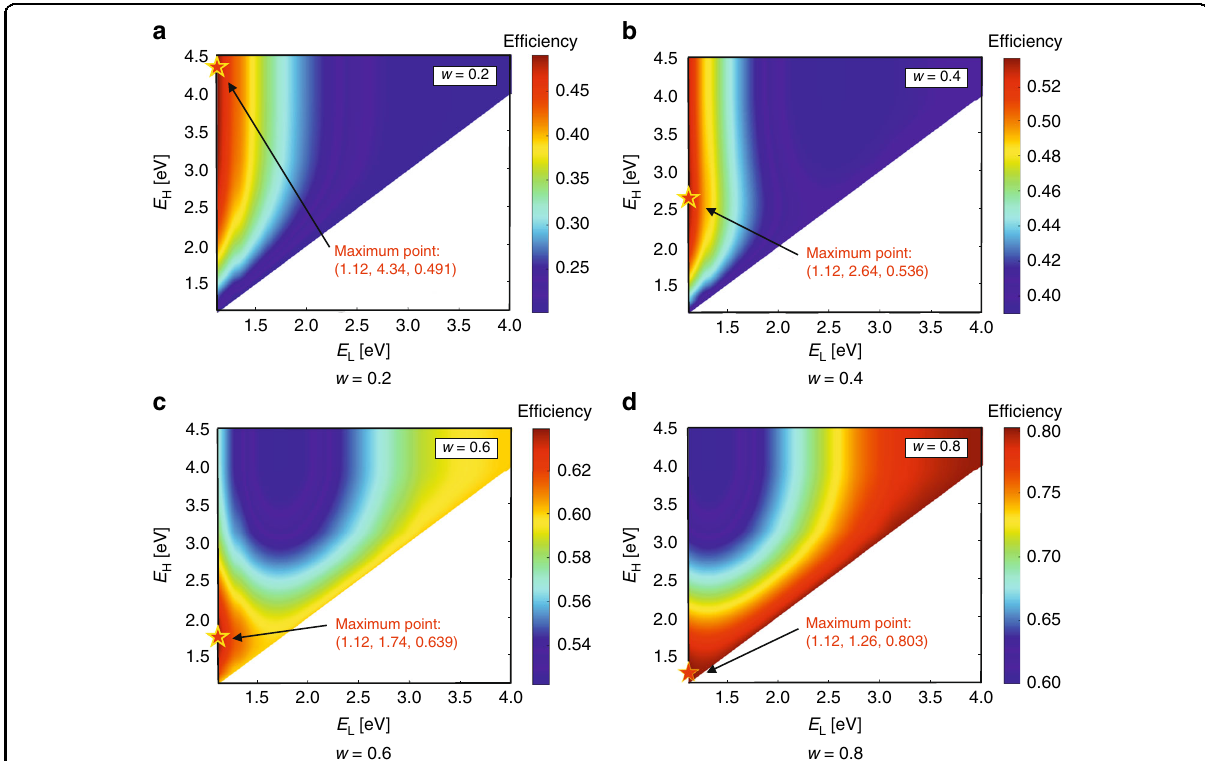
Fig. 8 Total effective ef fi ciency for different E L , E H and w -values ( C = 45,000, PV material: Si). The values stated at the maximum points are ( E L , E H , η tot ).